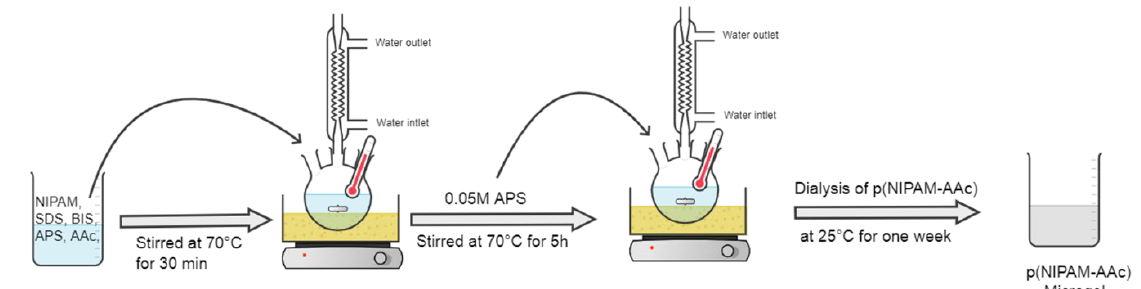
Figure 7. Schematic diagram of the synthesis of p(NIPAM-AAc) microgels.